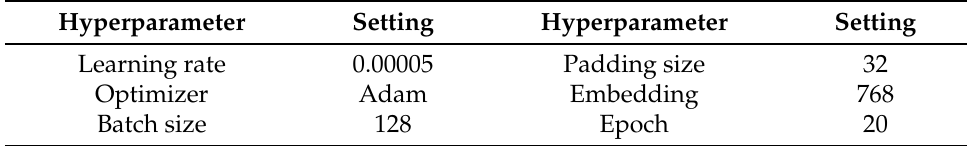
Table 2. The Hyperparameter settings of BERT-DTCN.